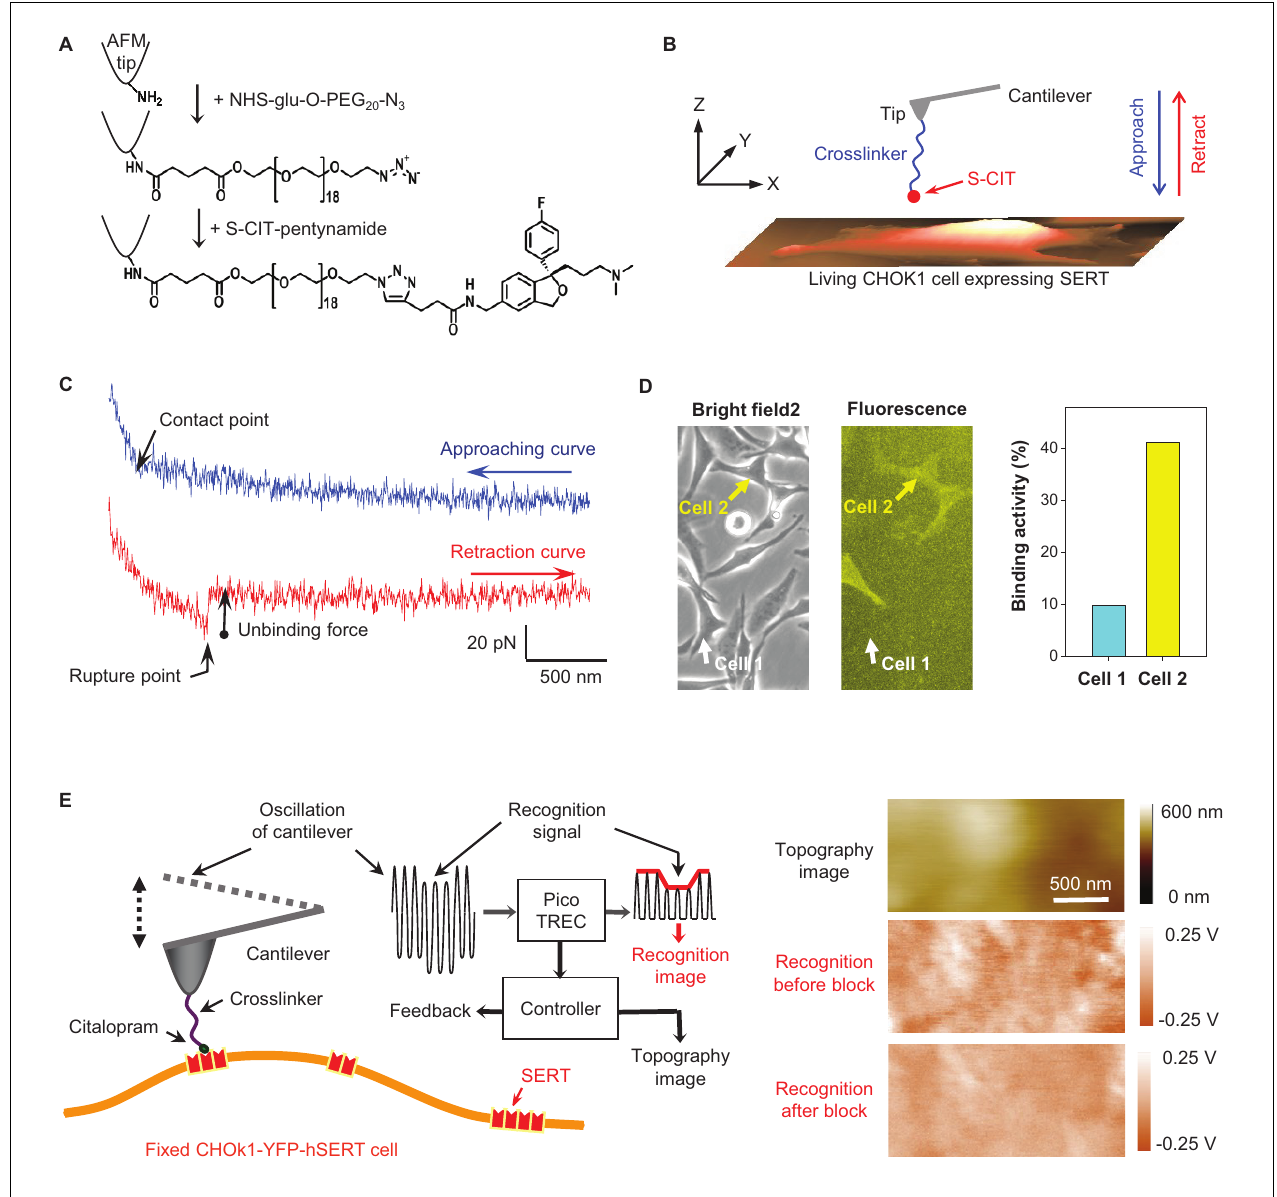
FIGURE 1 | (A) Conjugation of S-CIT to AFM cantilever tip. After the cantilever was amino-functionalized in the gas phase APTES (Riener et al., 2003), it was pegylated with NHS-glu-O-PEG 20 -N 3 (Zhu et al., 2015). Thereafter, the alkyne-modified S-CIT analog was coupled to the azido-terminated PEG via co-catalyst-accelerated copper(I)-catalyzed azide-alkyne cycloaddition (Lewis et al., 2004). (B) The S-CIT adorned cantilever tip was used to record force curves (C) on living CHOK1 cells expressing human SERT fused with YFP. (D) Cells seeded on the same dish showed different expression levels of SERT. The binding activity increased with the expression level, suggesting that the binding events arose from specific interactions between tip-coupled S-CIT and SERT. (E) Recognition imaging (principle shown in left part) revealed nano domains of SERT (shown as dark spots in the recognition image) in the cell membrane with diameters around 100–200 nm. After adding free CIT into the solution, the interaction between SERT and CIT-adorned AFM tip was blocked, resulting in the disappearance of the recognition spots (recognition image after block). (A–C) are reproduced from Zhu et al. (2015, 2018) with